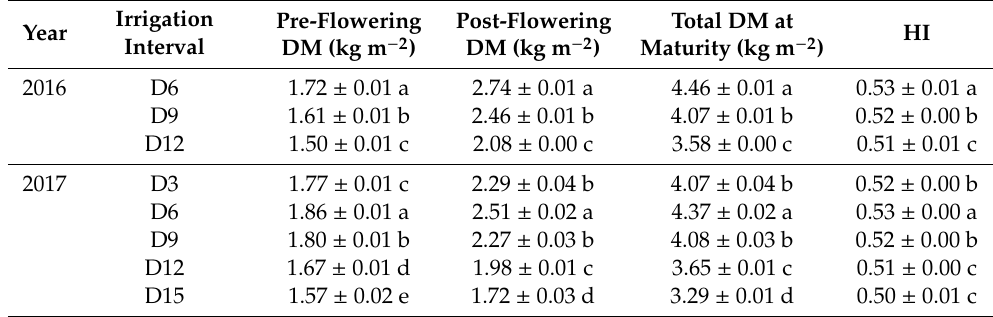
Table 2. Dry matter accumulation (DM) and harvest index at di ff erent irrigation